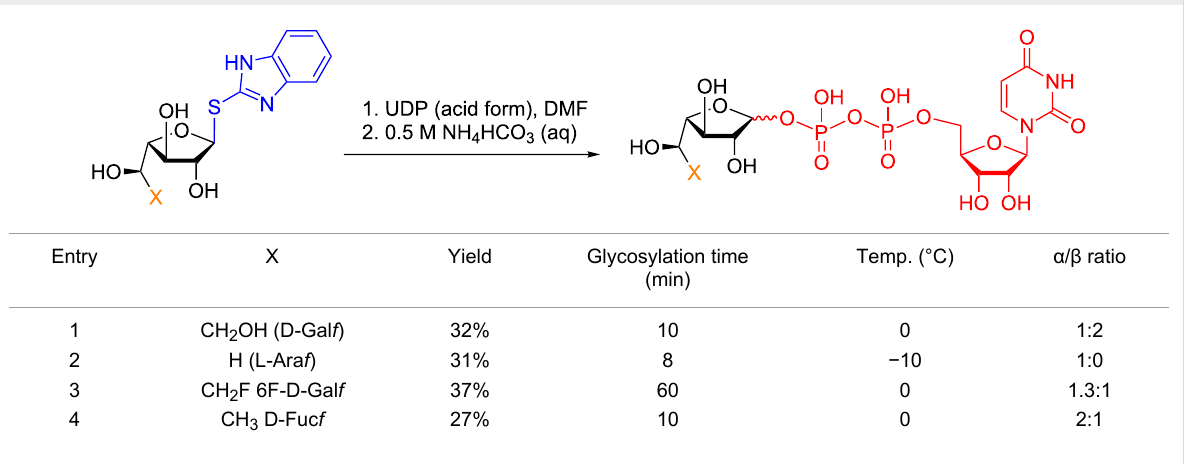
Table 3: Protecting-group-free UDP-furanoses using furanosyl 2-thiobenzimidazole-based